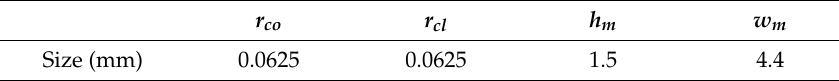
Table 2. Size of each layer in strain-transfer